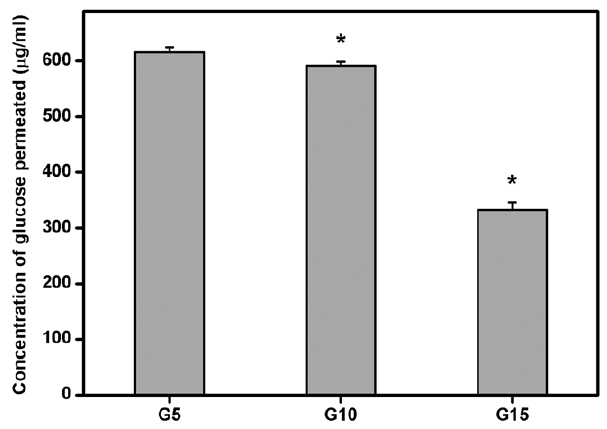
Figure 6. Glucose permeation studies. Concentration of glucose permeated through various gelatin discs at 34 u C. An asterisk indicates statistically significant differences (* P , 0.05; n =6) as compared with the G5